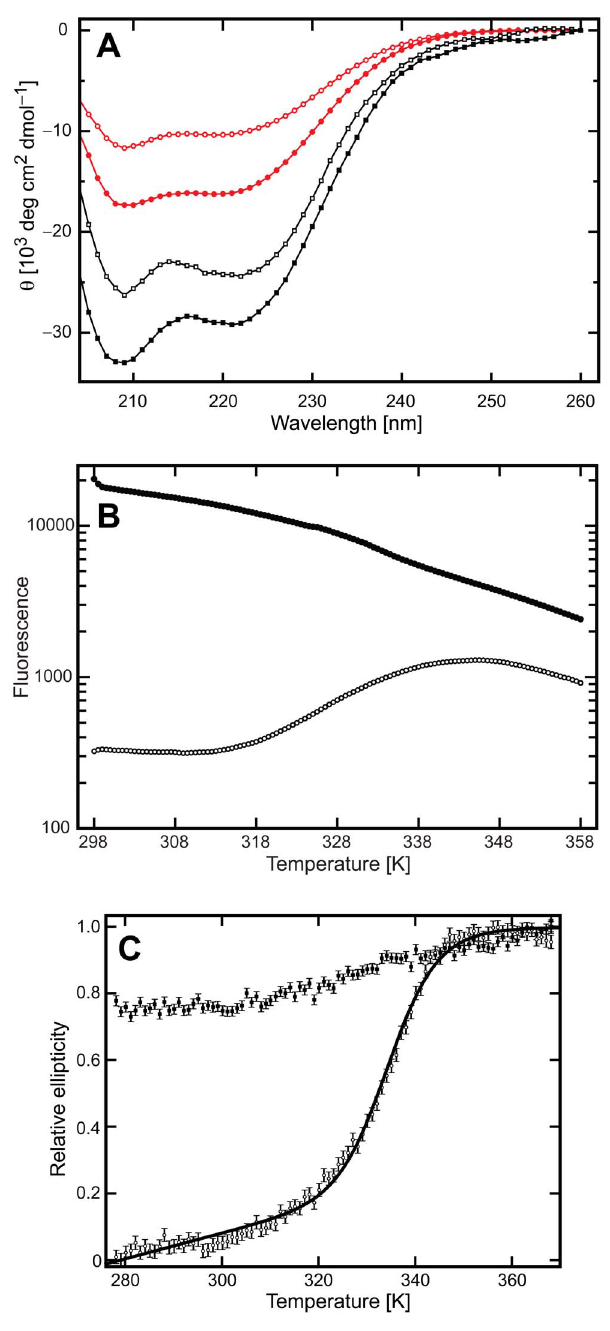
Figure 3. The DAPk-DD has intrinsically disorder protein properties. (A) Far-UV CD data of the GB1-corrected native DAPk- DD(L) (blue circles) and in the presence of 40% v/v TFE (green filled circles). The addition of 40% v/v TFE increased the DAPk-DD helicity by , 56% based on the 222 nm reading. The spectra for the GB1- subtracted FADD-DD in the absence (red circles) and presence of TFE (black filled circles), and an increase of , 18% in helicity was observed. Data collection in the presence of TFE were terminated at 204 nm because of the high tension voltage (dynode) registered at lower wavelengths. The high tension voltage arose from the buffer components, i.e., 20 mM sodium phosphate buffer, 150 mM NaCl, and 1 mM DTT, pH 7.4. Error bars are estimates of uncertainties derived from the three scans recorded per sample. (B) The fluorimetric thermal denaturation profile of the GB1-DAPk-DD(L) protein (solid circles) resembles a protein that is loosely structured with the fluorophore